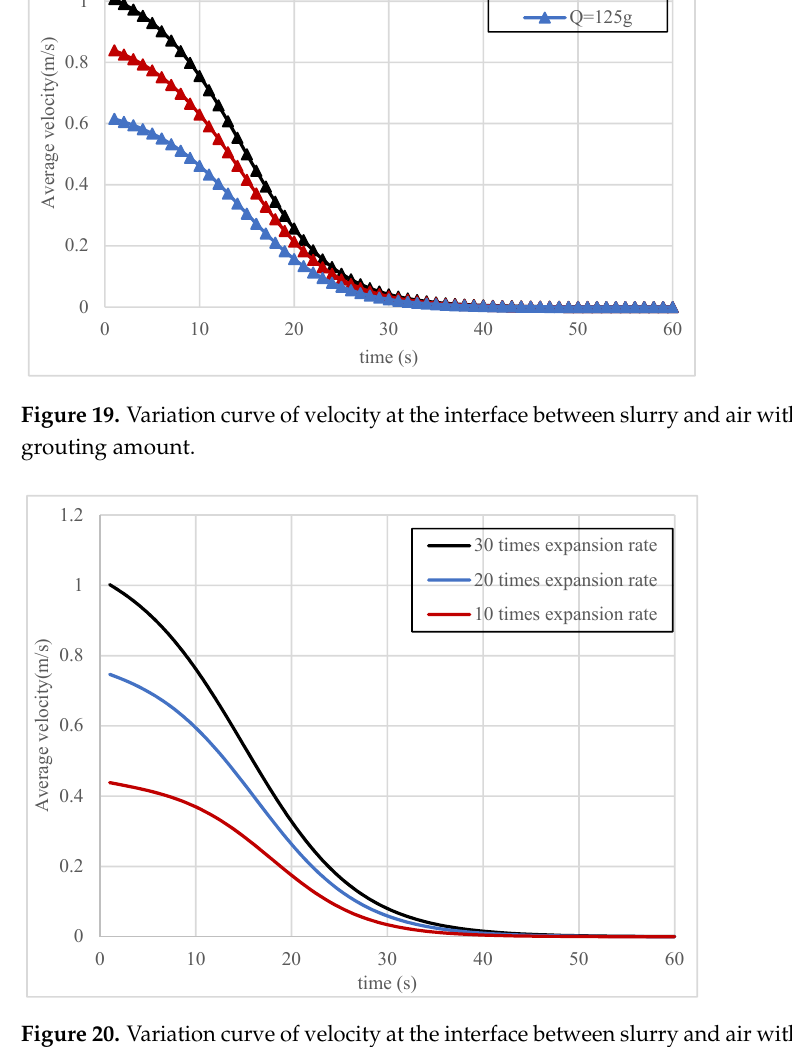
Figure 20. Variation curve of velocity at the interface between slurry and air with time under different expansion ratios.